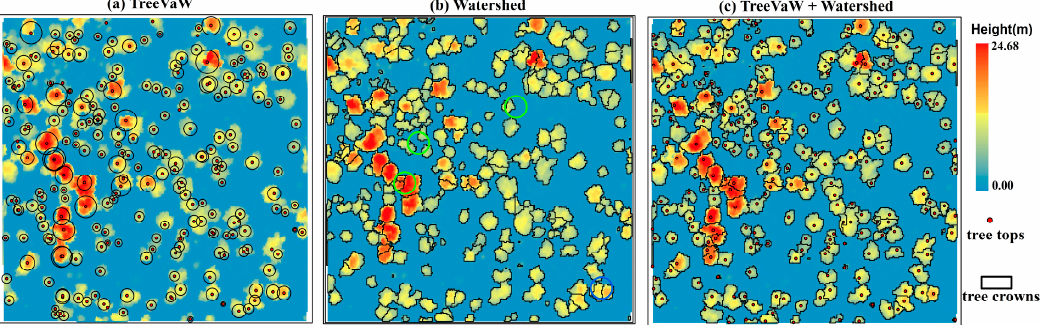
Figure 3. An example of tree segmentation with three approaches including the TreeVaW, watershed and TreeVaW + watershed (TW) algorithms.